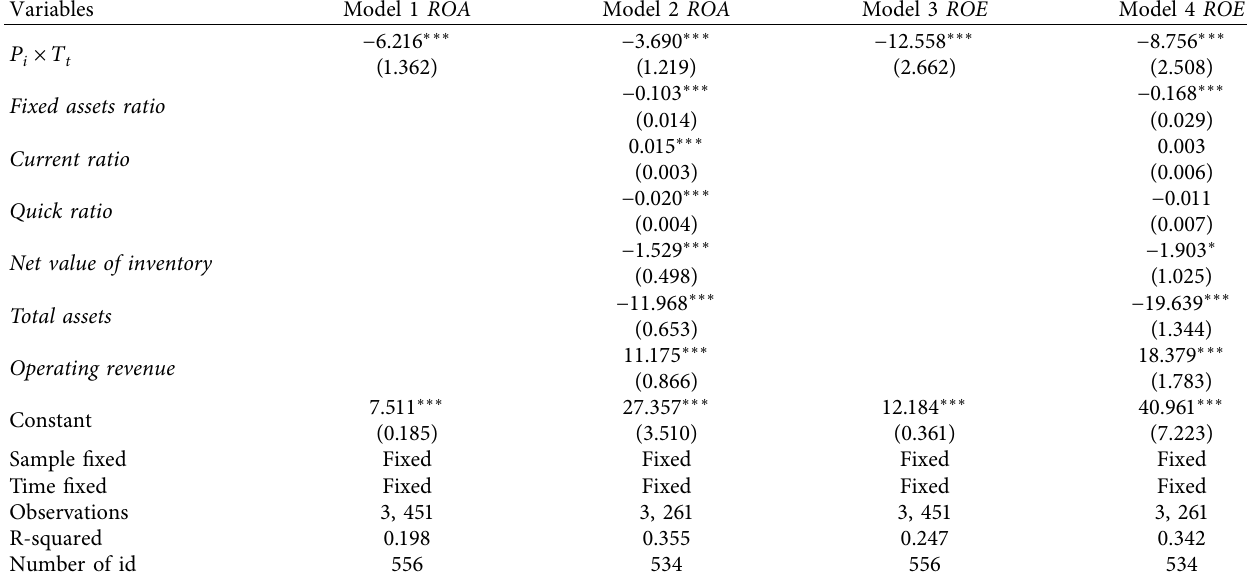
Table 1: Baseline regression